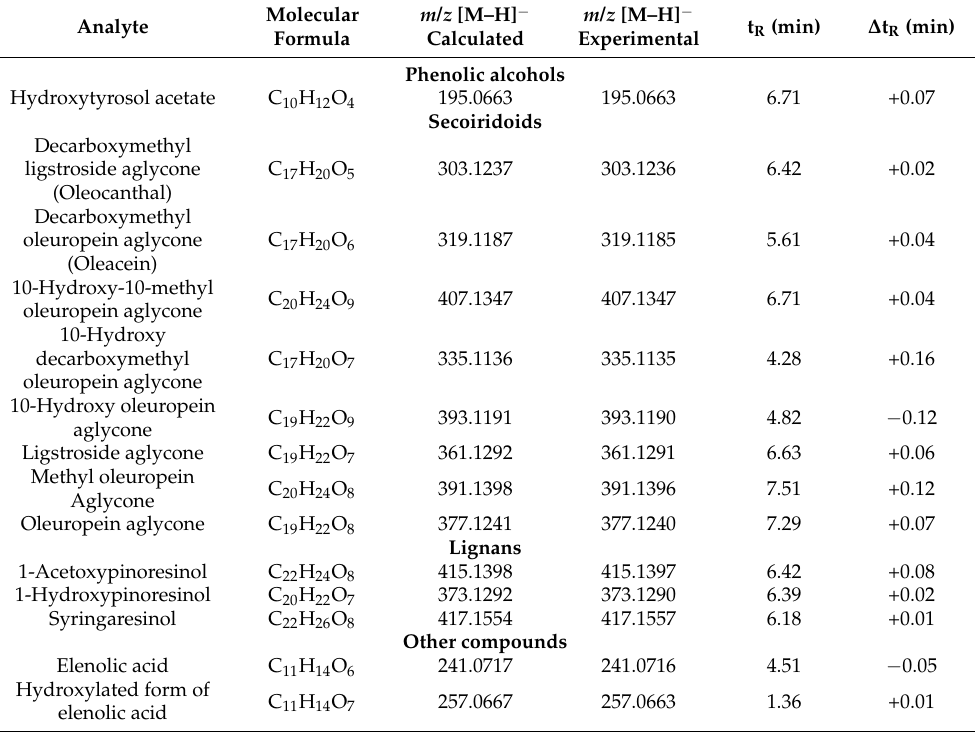
Table 2. Results of suspect screening for EVOOs.